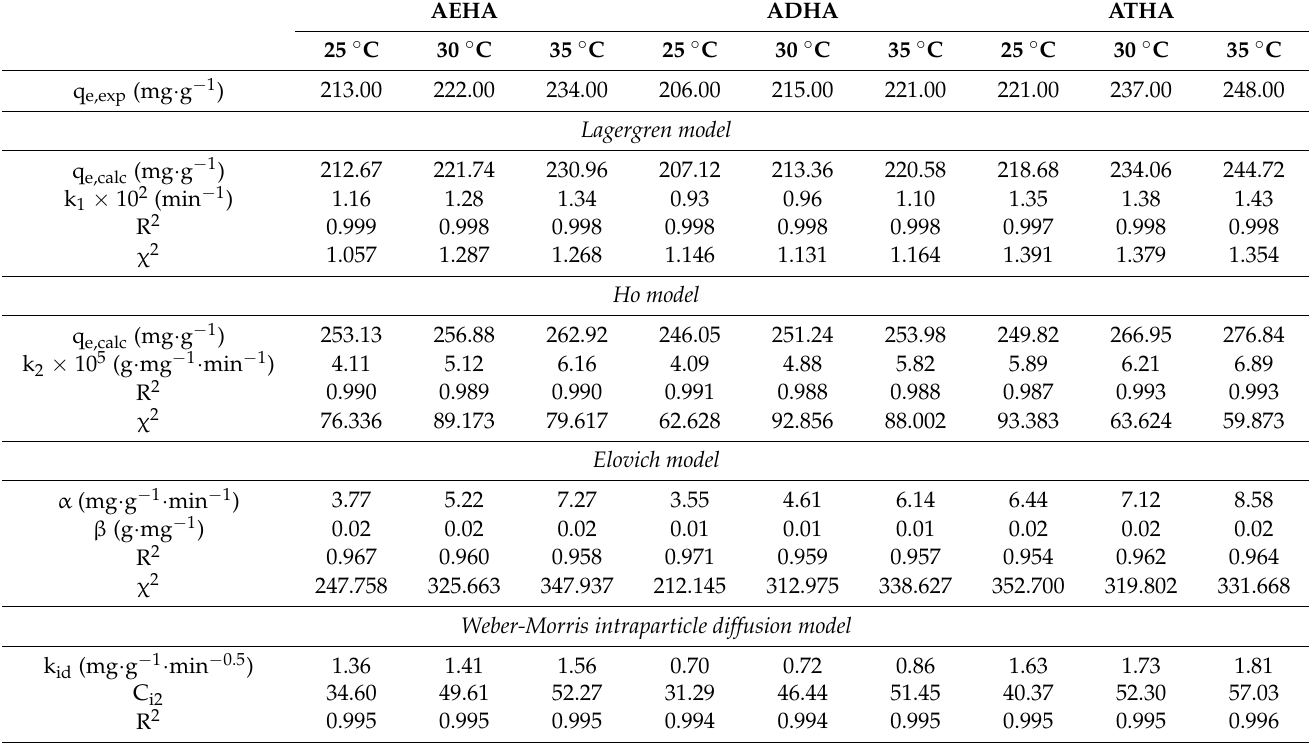
Table 11. Kinetic parameters for adsorption of metronidazole onto AEHA, ADHA and ATHA